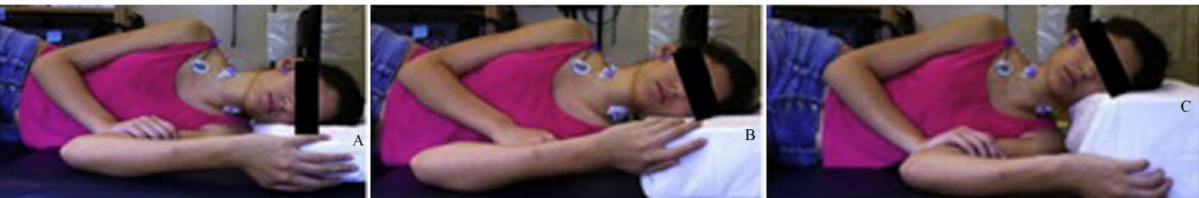
Figure 5. Electromyographic activity measurements of neck and shoulder muscles under three different pillow heights: 5 cm ( A ), 10 cm ( B ), and 14 cm ( C )